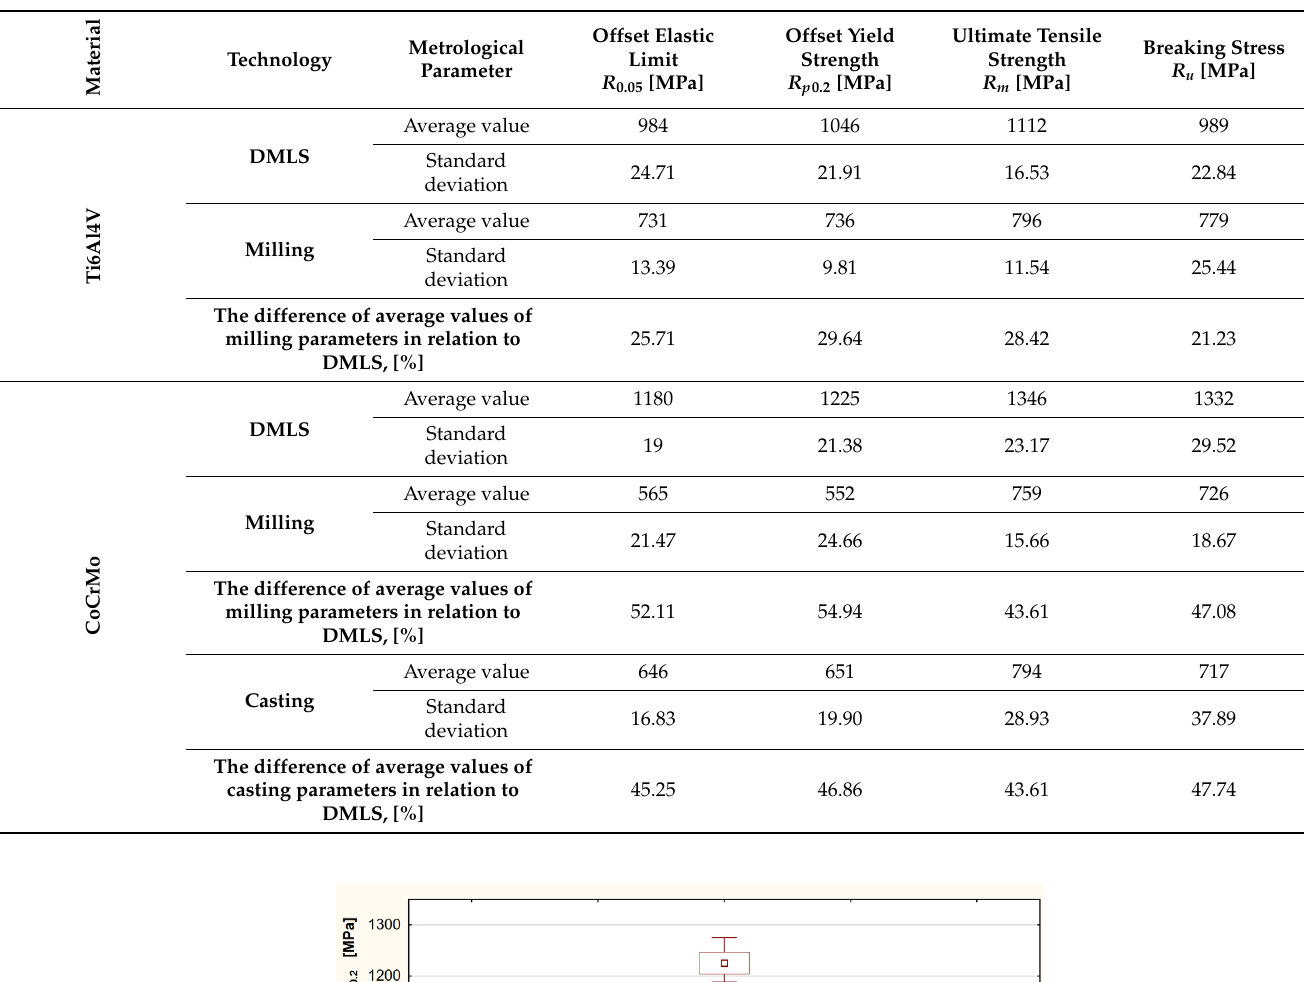
Table 1. List of strength parameters of the tested biomaterials, depending on the production technol- ogy, in axial tensile tests.